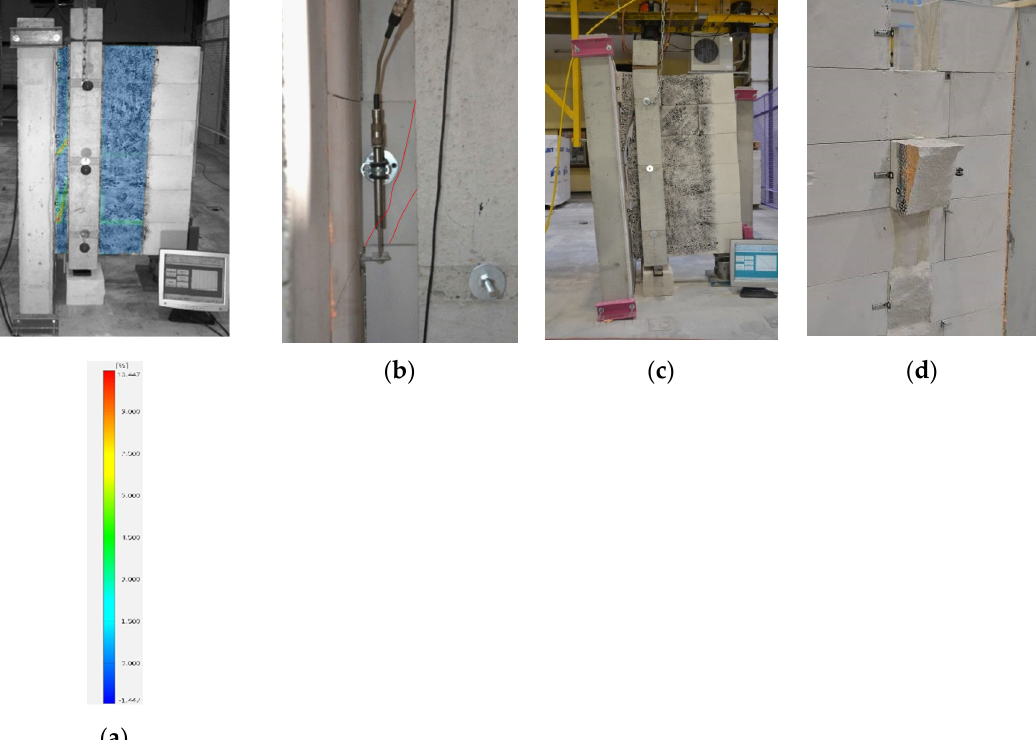
Figure 5. Relationship between the total force and mean displacement for test results and calculations. This phase was completed at maximum force values within the range N u = 38.6 – 59.8 kN. Continued attempts at loading in the failure phase resulted in a clear drop in the values of forces registered by a dynamometer, and an increment in relative displacements. Force was close to zero,